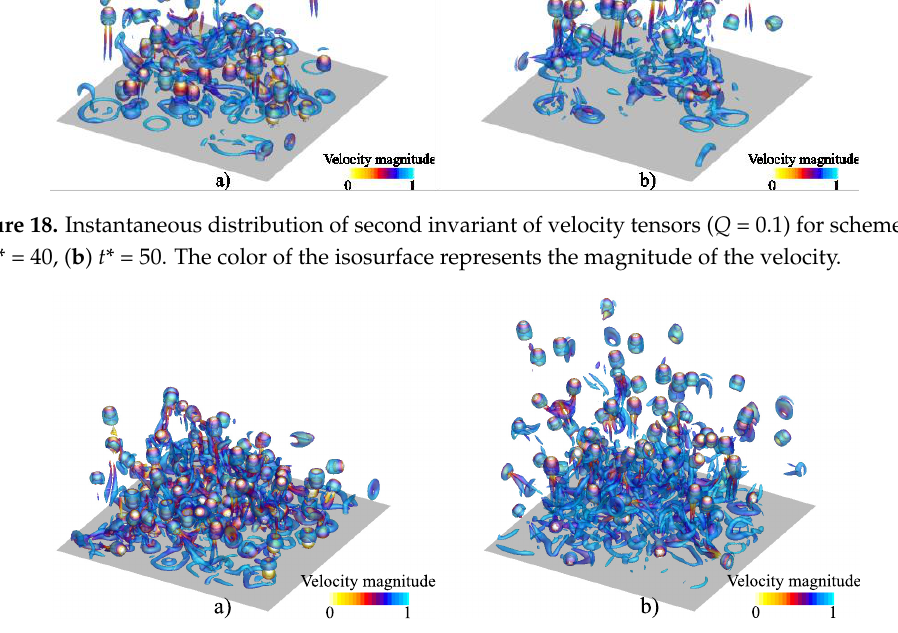
Figure 19. Instantaneous distribution of second invariant of velocity tensors ( Q = 0.1) for scheme B100: ( a ) t * = 40, ( b ) t * = 50. The color of the isosurface represents the magnitude of the velocity.